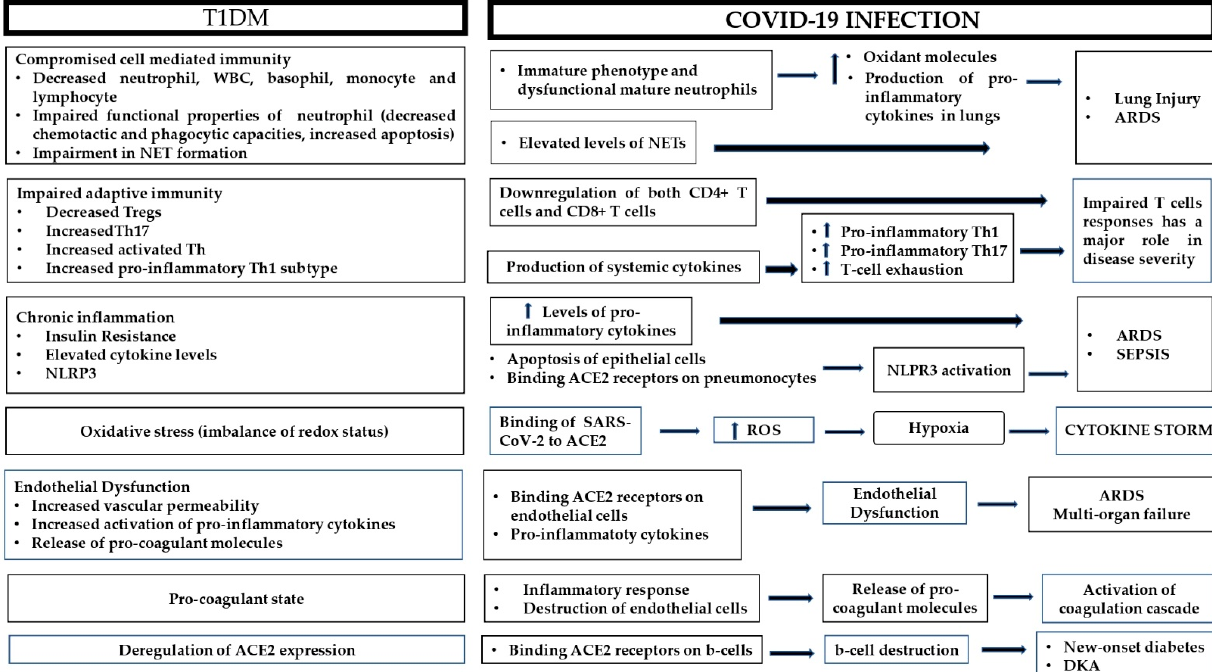
Figure 1. Possible pathophysiological mechanisms responsible for adverse outcomes during COVID-19 infection in patients with type 1 diabetes. ARDS: acute respiratory distress syndrome; ACE2: angiotensin converting enzyme 2; DKA: diabetic ketoacidosis; NET: neutrophil extracellular trap; NLRP3: NOD-like receptor family pyrin domain-containing 3; ROS: reactive oxygen species; Th: T ‐ helper; Tregs: regulatory T ‐ cells; WBC: white blood cells.